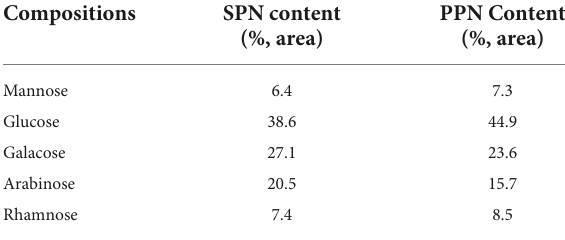
TABLE 2 Monosaccharide analysis